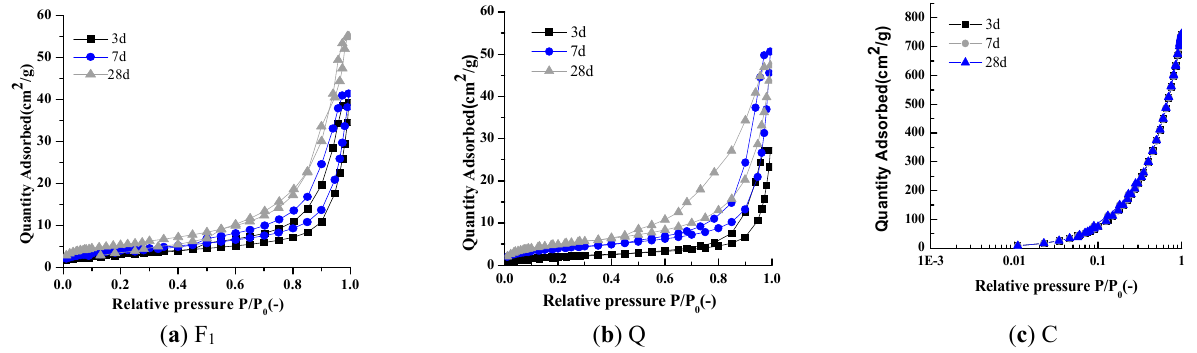
Figure 6. Isothermal nitrogen adsorption/desorption curves of the hardened pastes with ( a ) F 1 , ( b ) Q and ( c ) C at different ages.